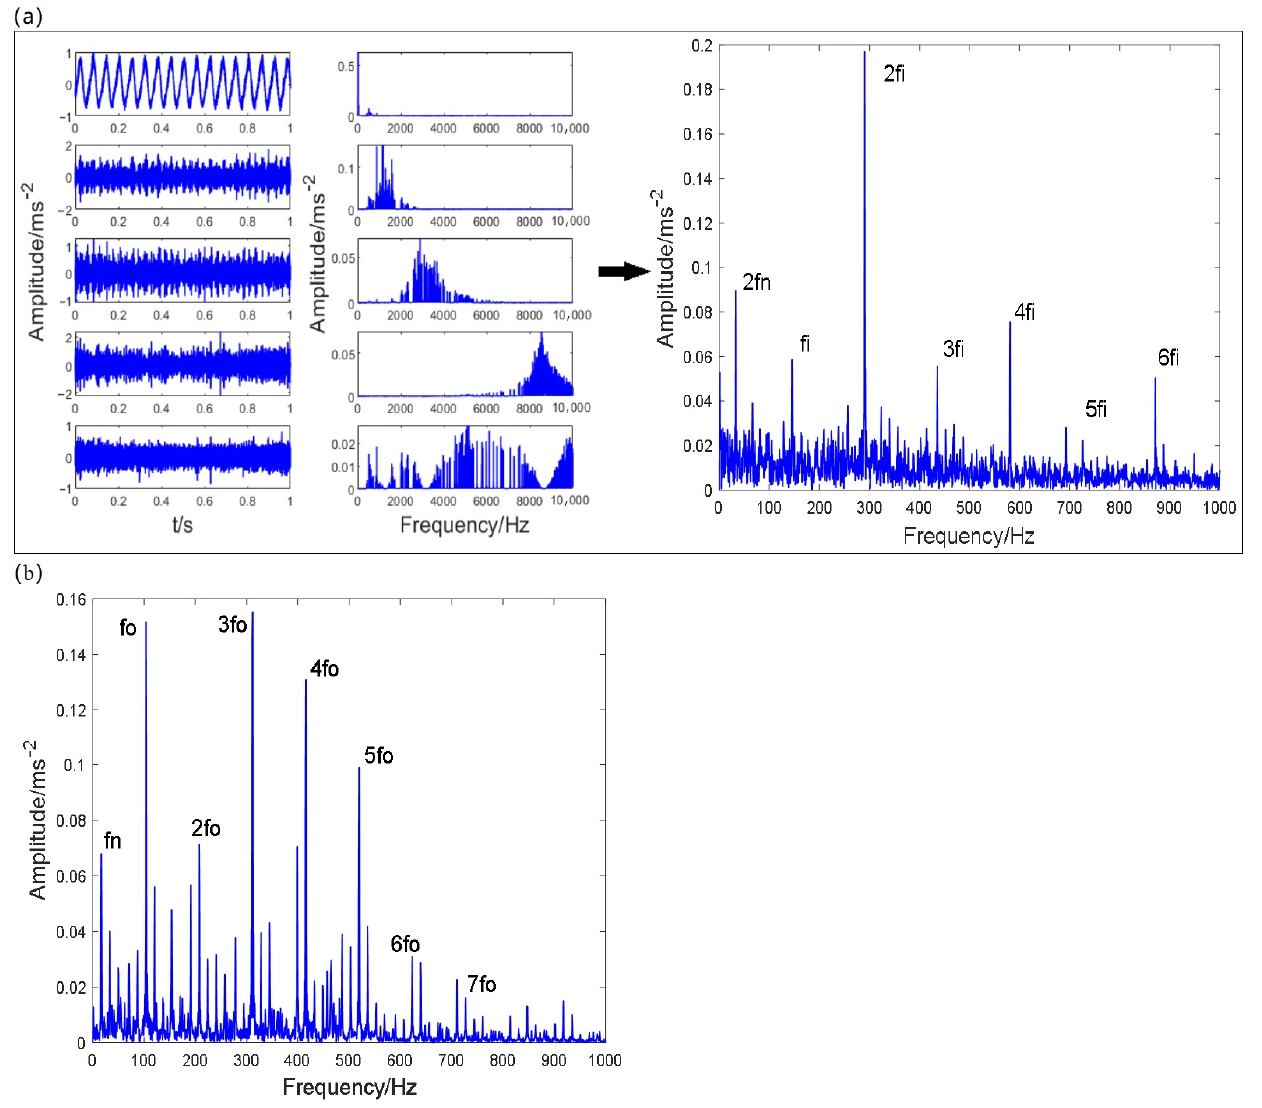
Figure 9. The application effect of RWOA-VMD on the vibration signals of vibrating screen exciter: ( a ) inner ring fault and ( b ) outer ring